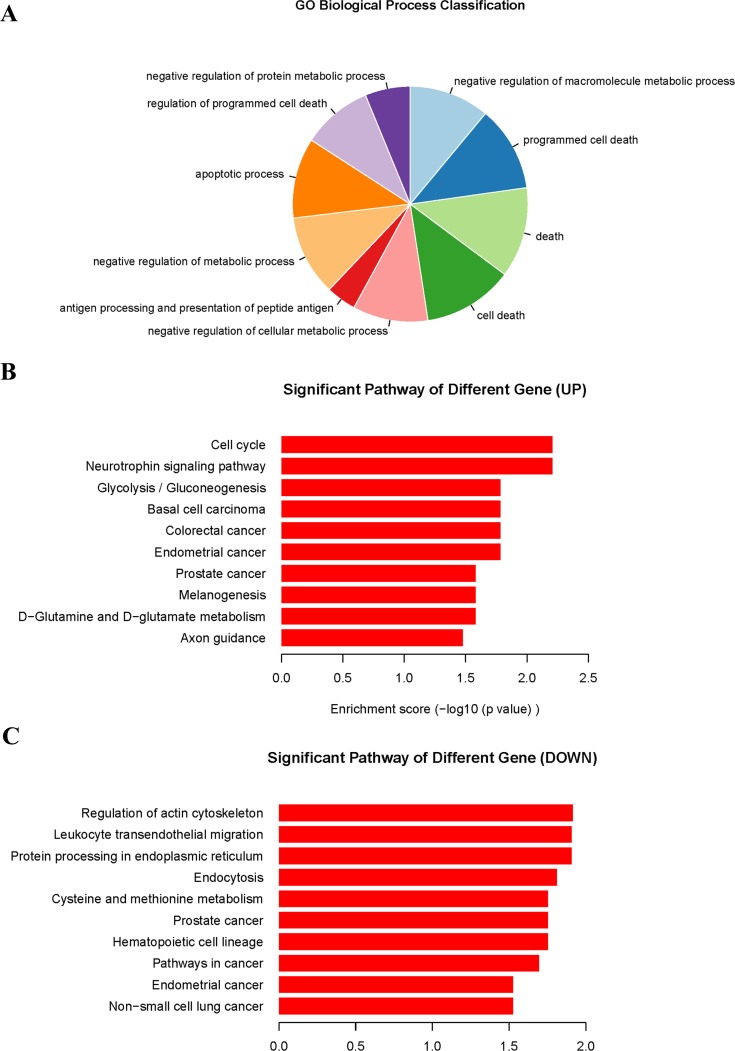
GO biological process and KEGG pathway analysis of the differentially express genes after IMB5043 treatment.(A). The top ten down-regulated terms in GO biological process classification. (B). The top ten significant up-regulated pathways in KEGG pathway analysis. (C). The top ten significant down-regulated pathways in KEGG pathway analysis. SMMC-7721 cells were treated with 1 μM IMB5043 for 24 h. The total RNA is isolated and used for gene microarray analysis.